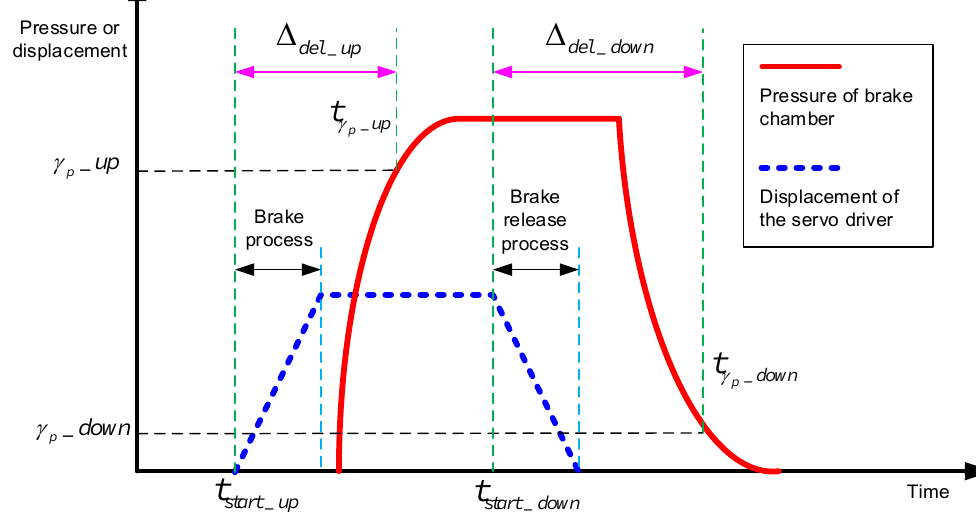
Figure 8. The working procedure of the PBS.